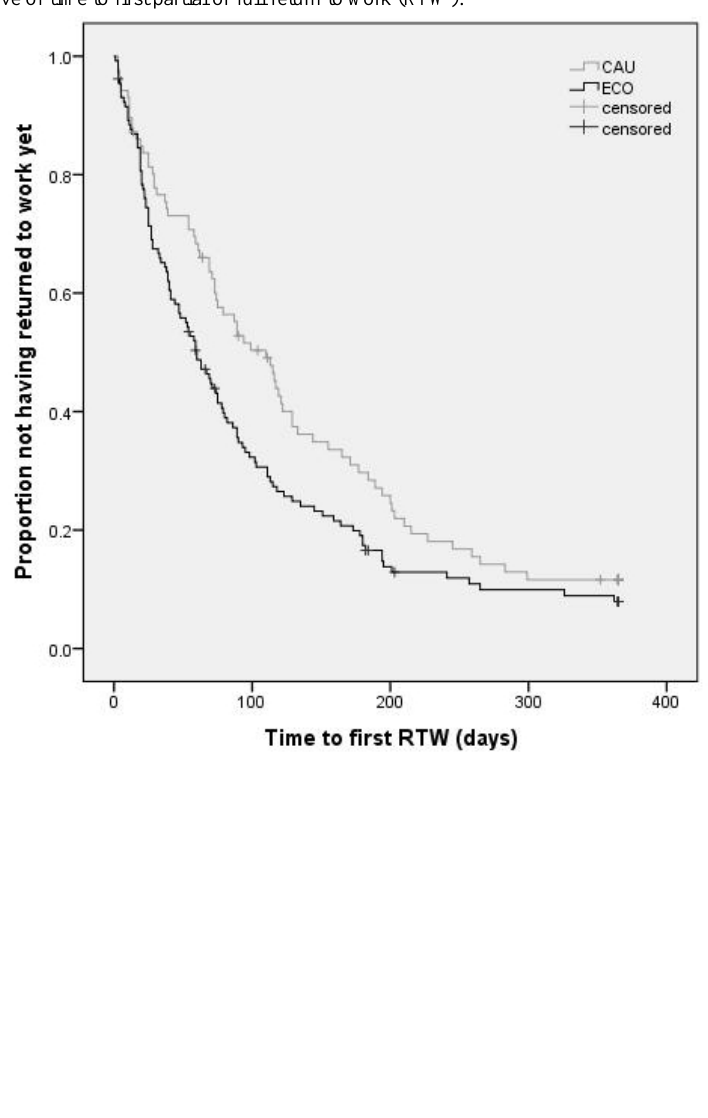
Figure 4. Kaplan-Meier curve of time to first partial or full return to work